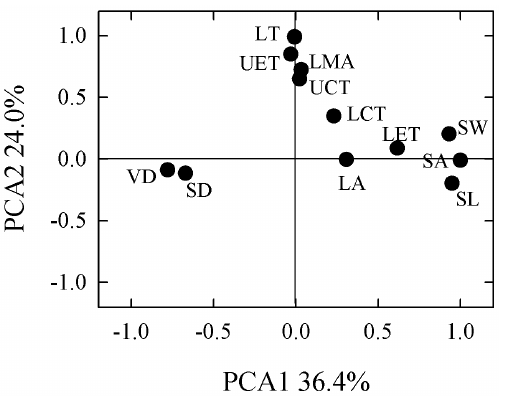
Figure 3. Factor-loading for stomatal and leaf traits along 2 axes of principal component analysis (PCA). SL, stomatal length; SW, stomatal width; SA, stomatal area; SD, stomatal density; UET, upper epidermal thickness; UCT, upper cuticular thickness; LET, lower epidermal thickness; LCT, lower cuticular thickness; LMA, leaf mass per unit area; LA, leaf area; VD, vein density; and MT, mesophyll thickness.